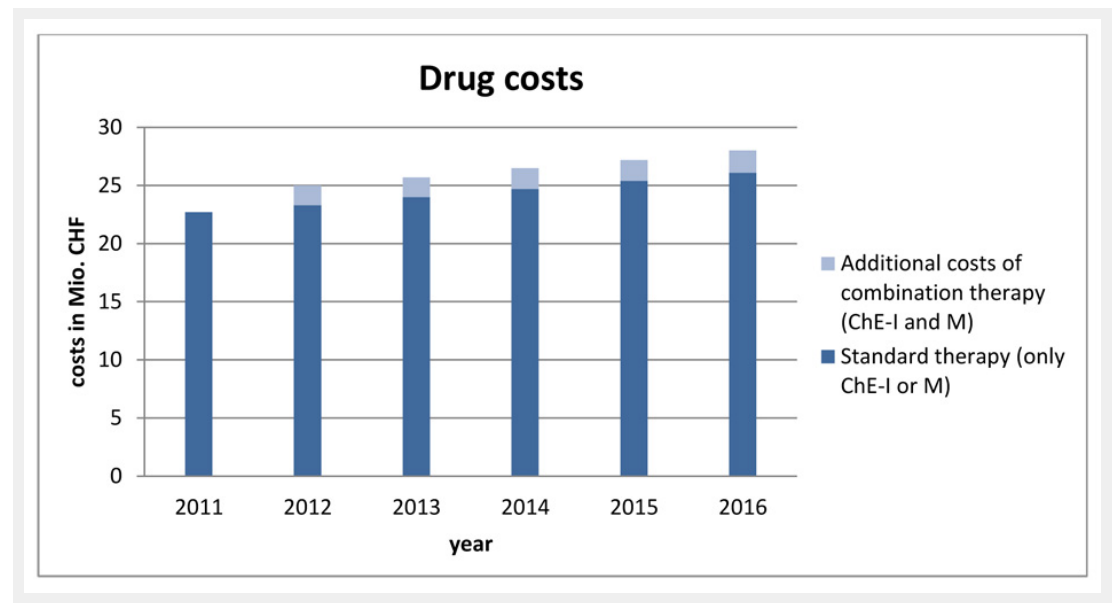
Calculated medication costs for the years